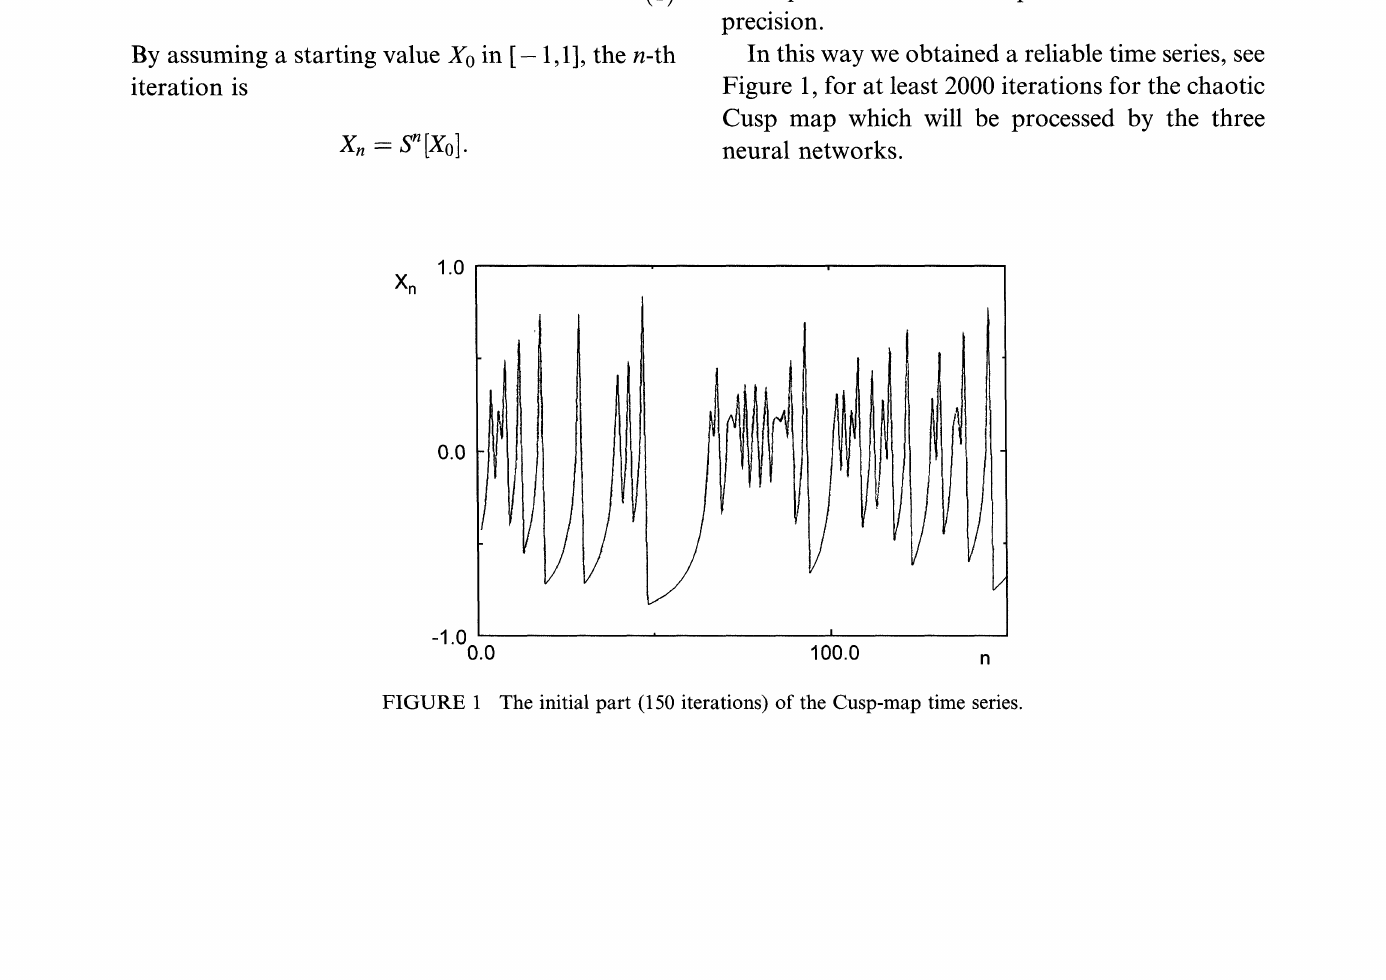
FIGURE The initial part (150 iterations) of the Cusp-map time